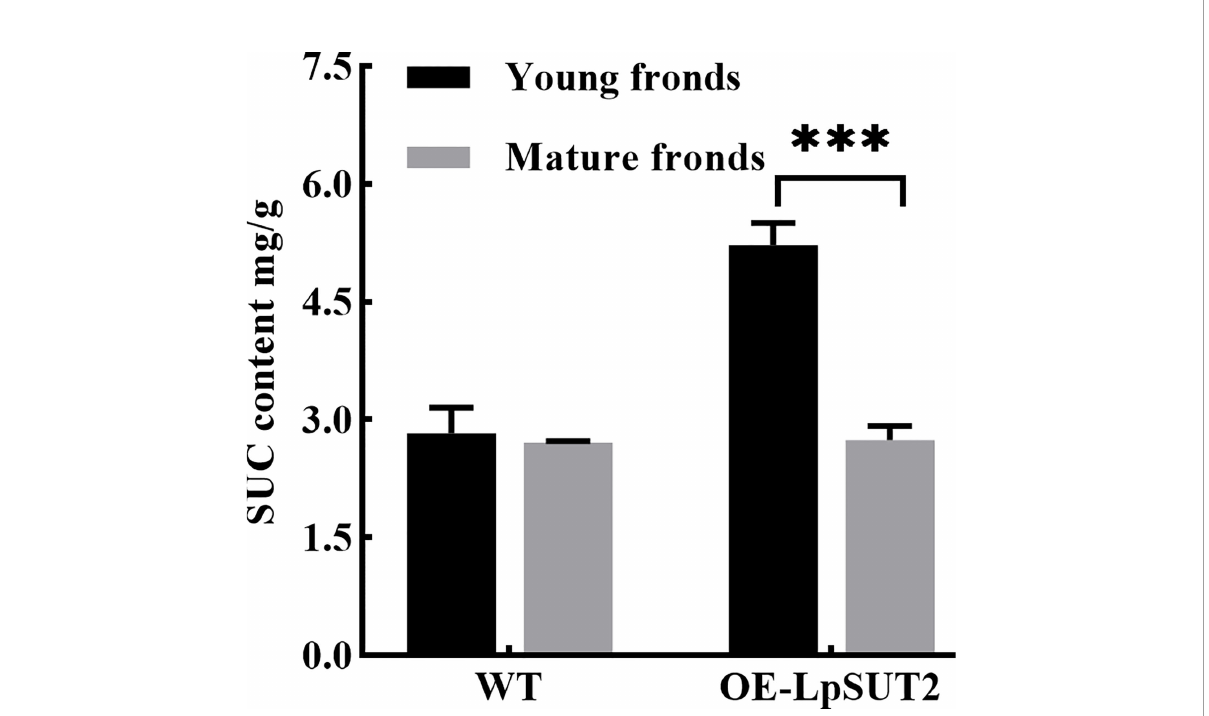
FIGURE 6 Variation of sucrose content during duckweed growth. The changes of sucrose content in WT and LpSUT2 overexpression lines during its growth were determined using an evaporative light-scattering detector (All-Tech ELSD 2000, All-tech, Crop, USA) of HPLC (high-performance liquid chromatography) system (Thermo 2795, Thermo Corp, USA). The content of sucrose in the overexpressed LpSUT2 lines signi fi cantly decreased from initial values of 5.02 to 2.61 mg/g during the development from young to mature fronds. The bars indicate the mean value±SD of three independent experiments (***P<0.001). WT, Wild type; LpSUT2, Sucrose transporter 2 of L. punctata ; OE,